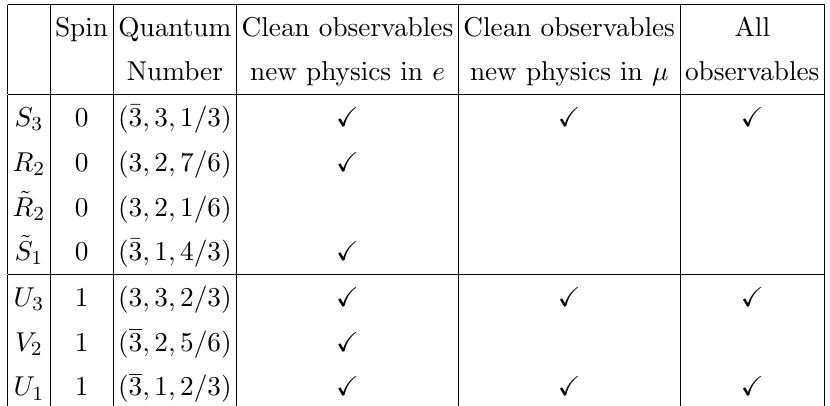
Table 3 . Which lepto-quarks can reproduce which b